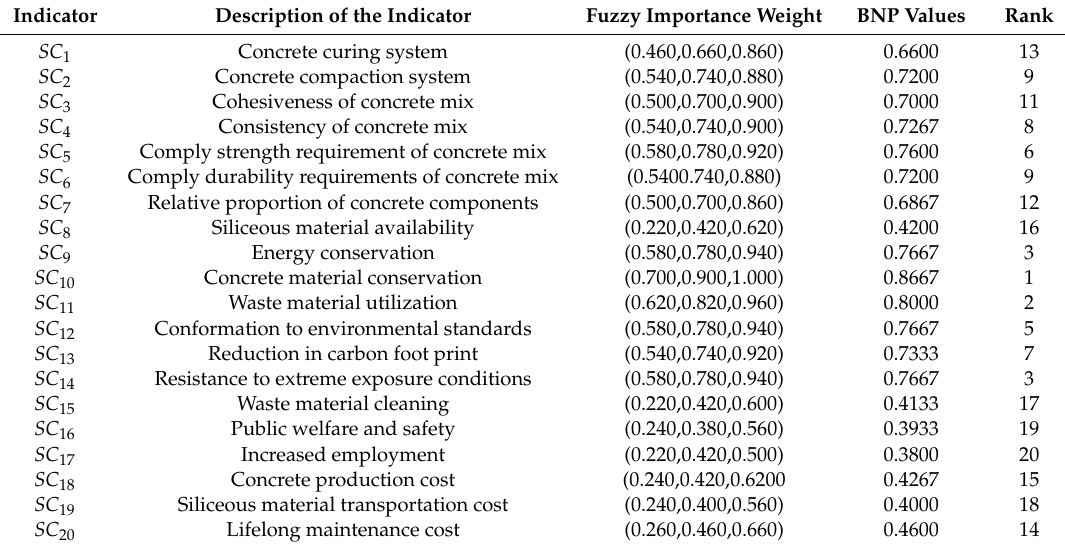
Table 2. Fuzzy importance weight, best non-fuzzy performance (BNP), and rank of each indicator.